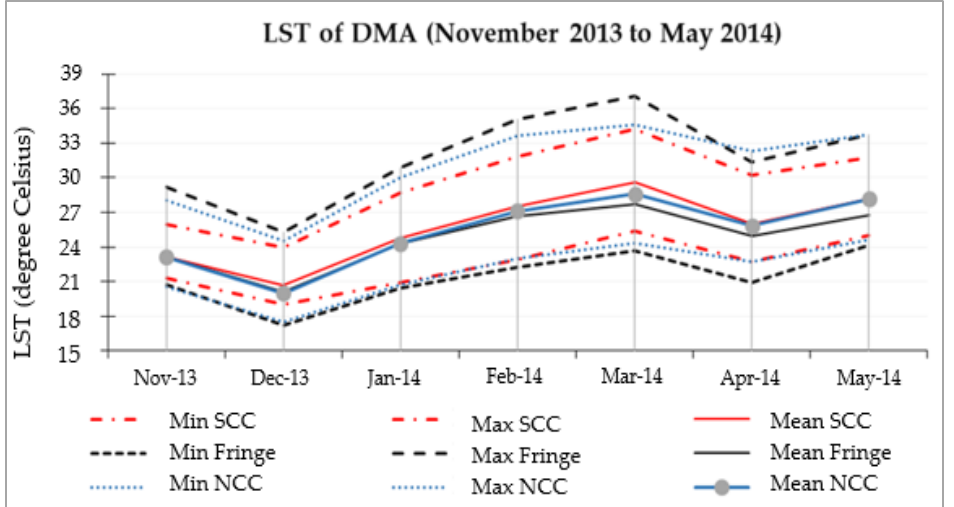
Figure 13 . Maximum, Minimum, and Mean LST of DMA with seasonal variation